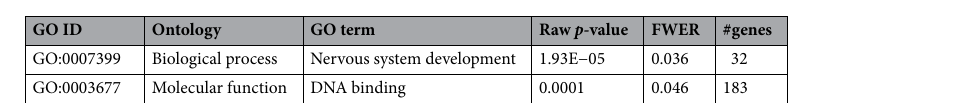
Figure 2. Overlapping differentially expressed genes between blood RNA-seq from individuals with 15q13.3 microdeletion and mouse (Df[h15q13]/+) brain cortex. ( A ) Venn diagram showing the number of differentially expressed genes in the present study (Human) and the mouse (Df[h15q13]/+) brain cortex datasets of Gordon et al. 19 and Al-Absi et al. 12 . ( B ) Heatmap of RNA-seq expression z-scores computed using blood RNA-seq data for the 23 overlapping differentially expressed from all three studies. Each column in the heatmap is an individual sample (control = control individuals, test = 15q13.3 microdeletion individuals).